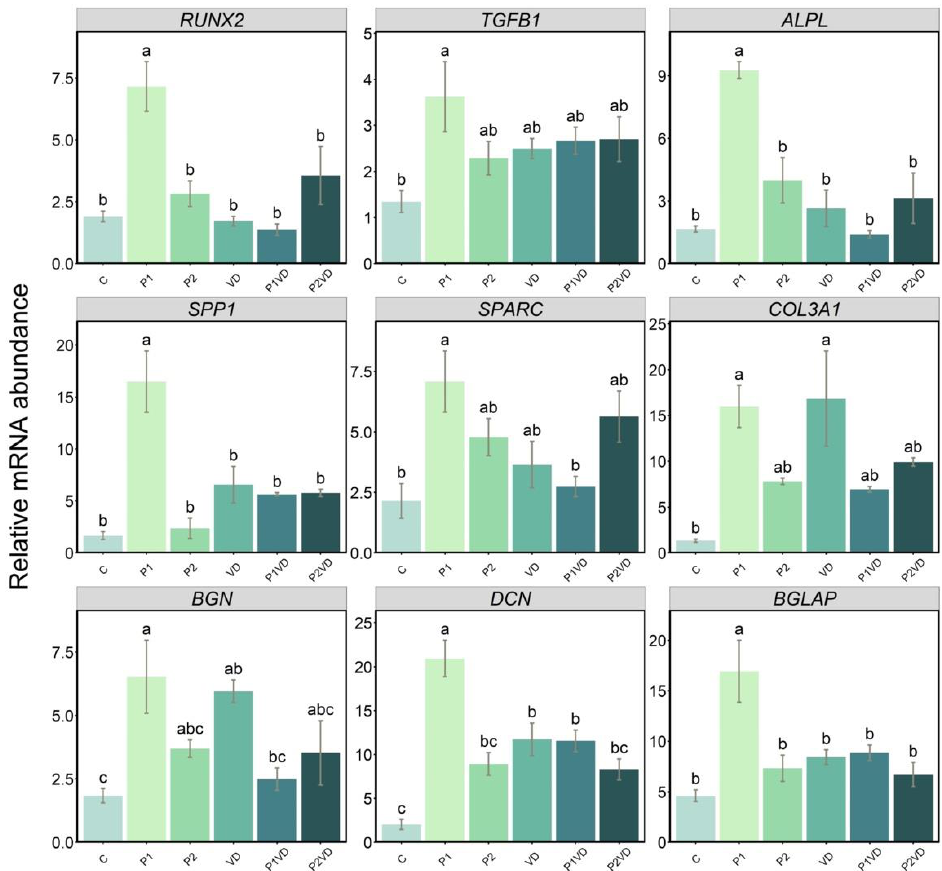
Figure 5. Expression of genes involved in the osteoblast proliferation, maturation, and mineralization of the ECM, in cells cultured without any treatment (C), treated with VD (VD), with two probiotics (P1 and P2) and their respective combinations with VD (P1VD and P2VD). Data are shown as means ± SD as error bars. One-way ANOVA was used to analyze the difference between the groups and Tukey’s post hoc test was used for multiple comparisons among groups. Different letters above each column denote statistically significant differences among experimental groups ( n = 4, p < 0.05). Three groups that differ significantly from each other are labelled a, b, and c, and two that differ from each other but not from the third are labelled a, b, and ab.